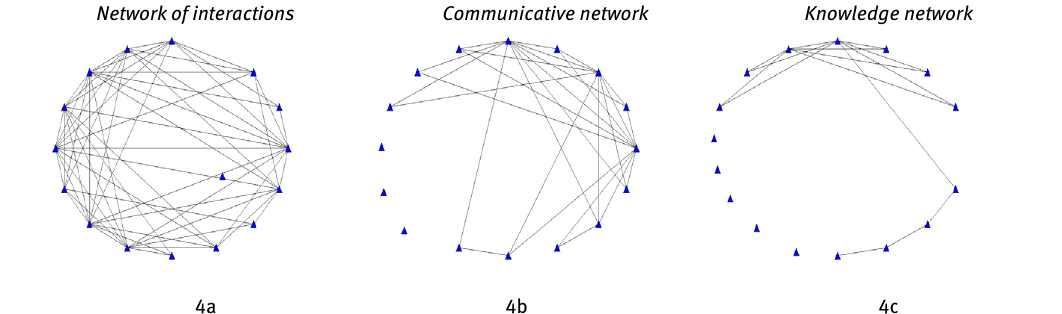
Figure 4: The socio-institutional